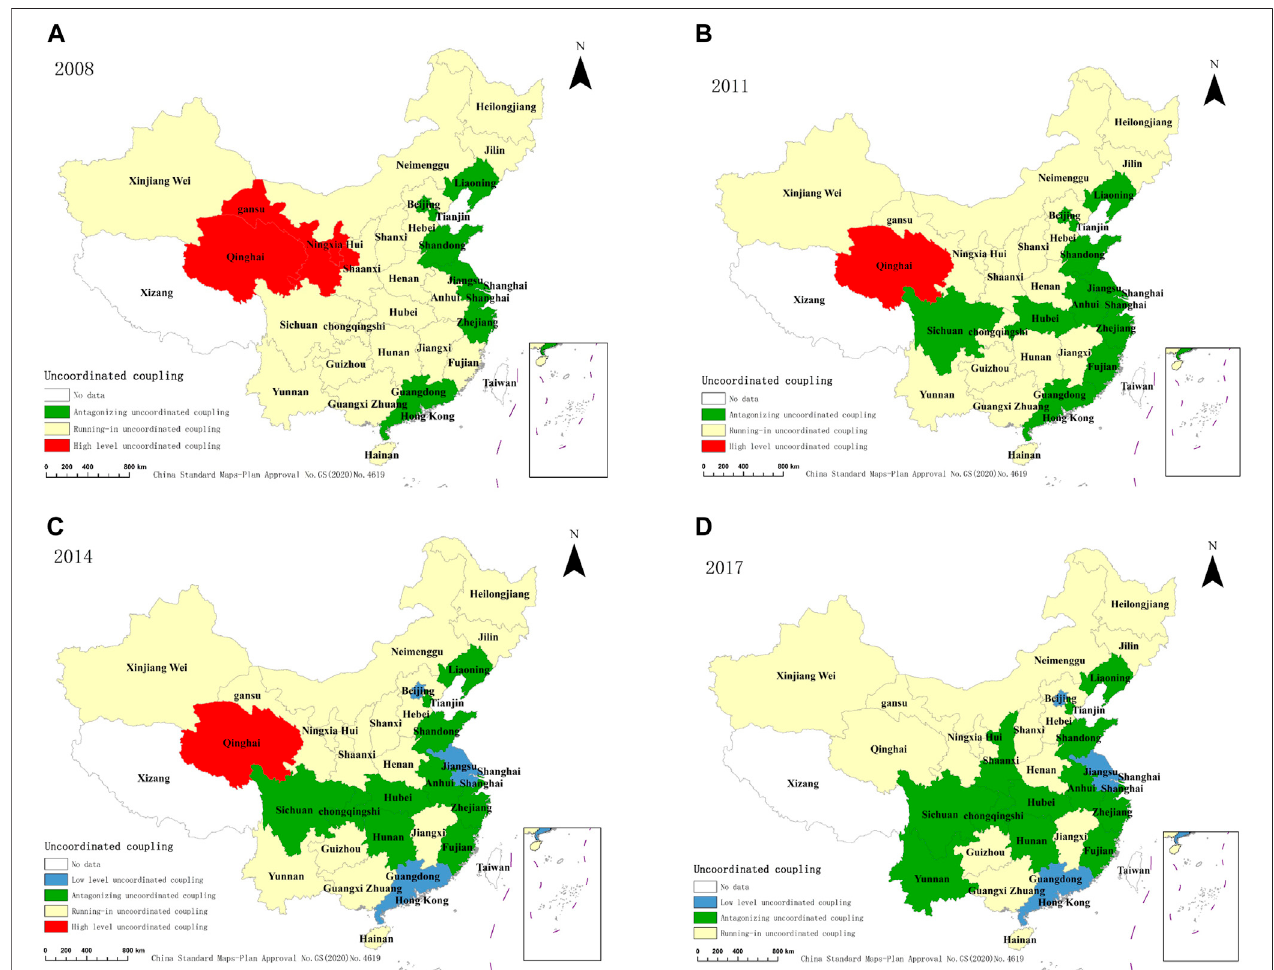
FIGURE 4 | Temporal and spatial difference evolution of UCCD between STDL and LCEE. (A) China ’ s provincial UCCD in 2008; (B) China ’ s provincial UCCD in 2011; (C) China ’ s provincial UCCD in 2014; (D) China ’ s provincial UCCD in 2017.